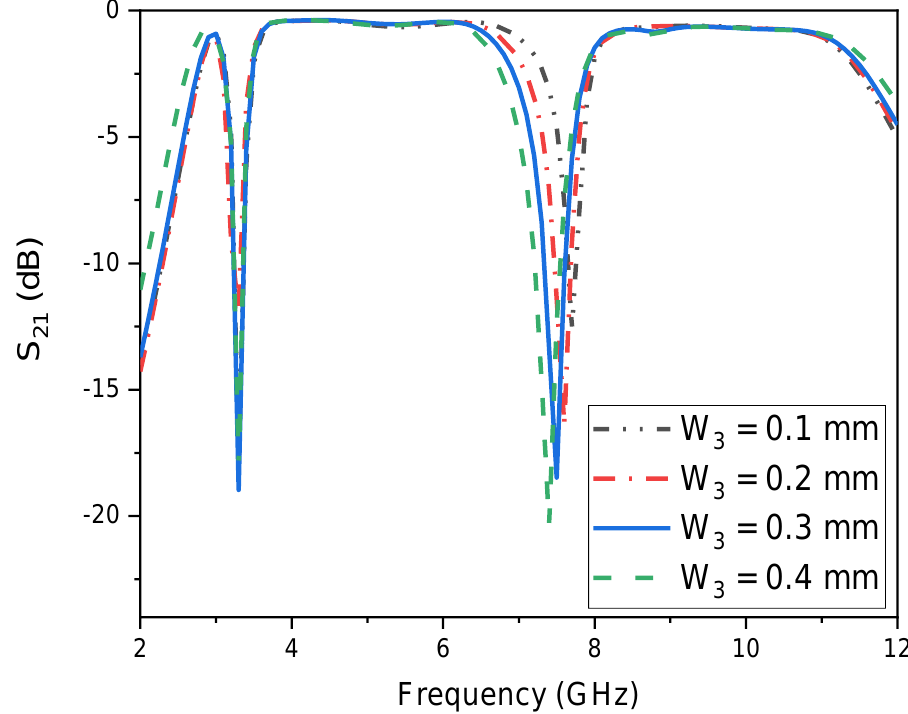
Figure 16. S 21 plot of second band control with parameter W 3 .